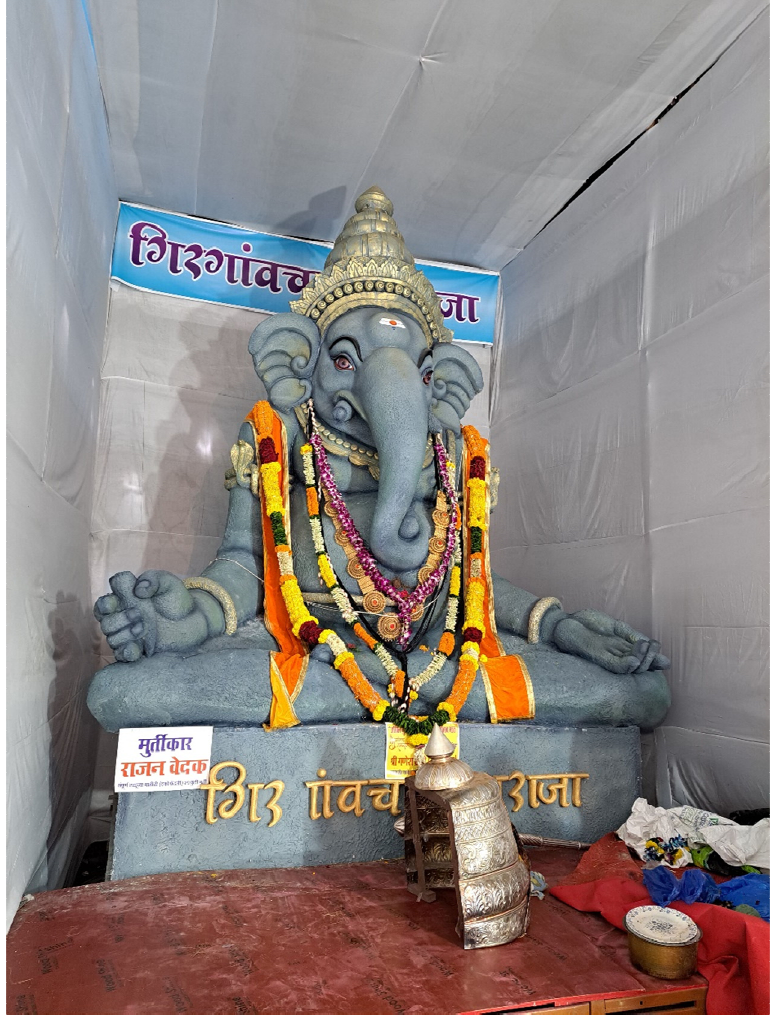
Figure 8. Girgaon cha maharaja Ganesha made of shadu chi mati (type of clay). Picture taken by author, 9 September 2022, Mumbai.